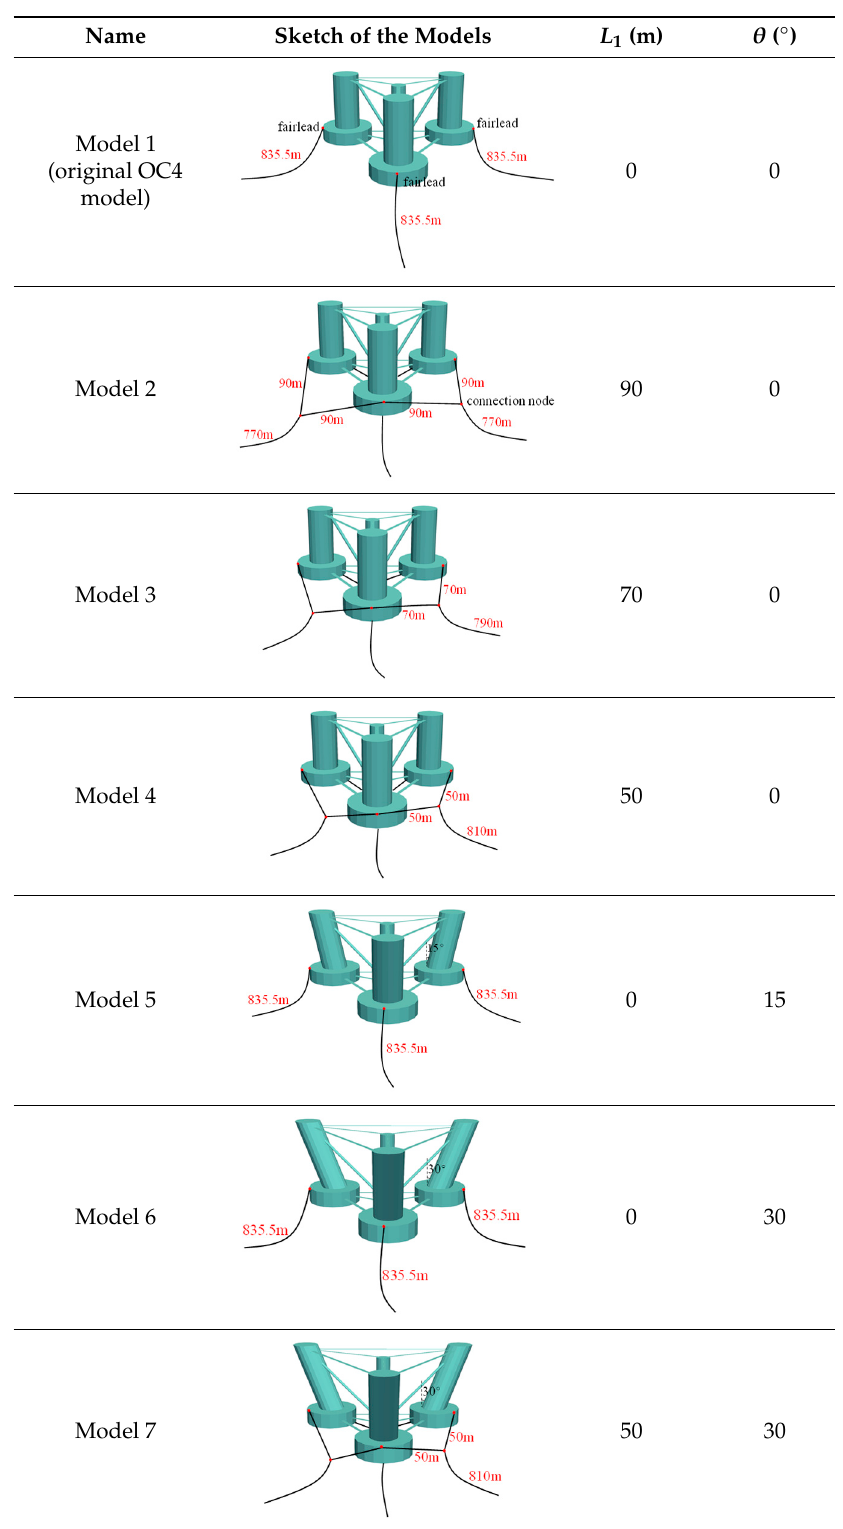
Table 4. Models examined in the present study.